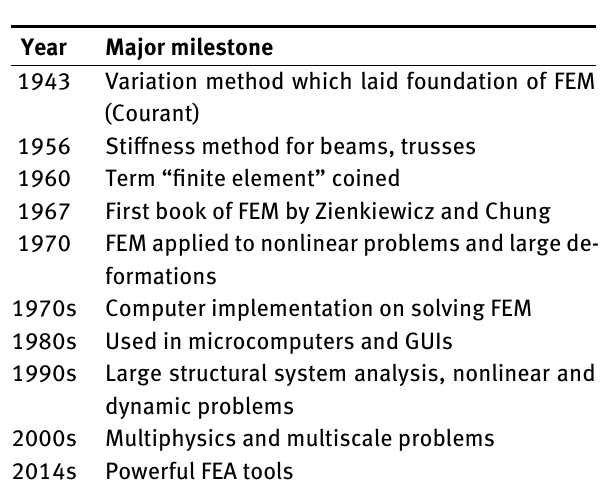
Table 4: Type and number of equations in 1D, 2D, and 3D